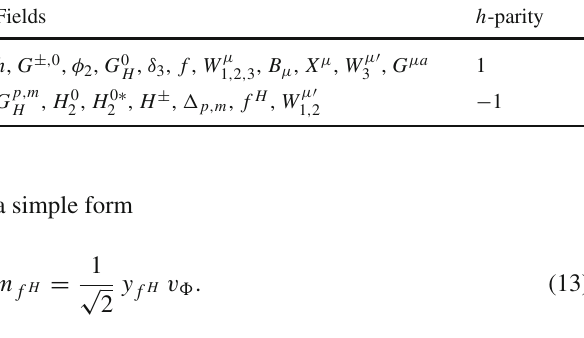
Table 2 Classification of all the fields in G2HDM under h -parity Fields h